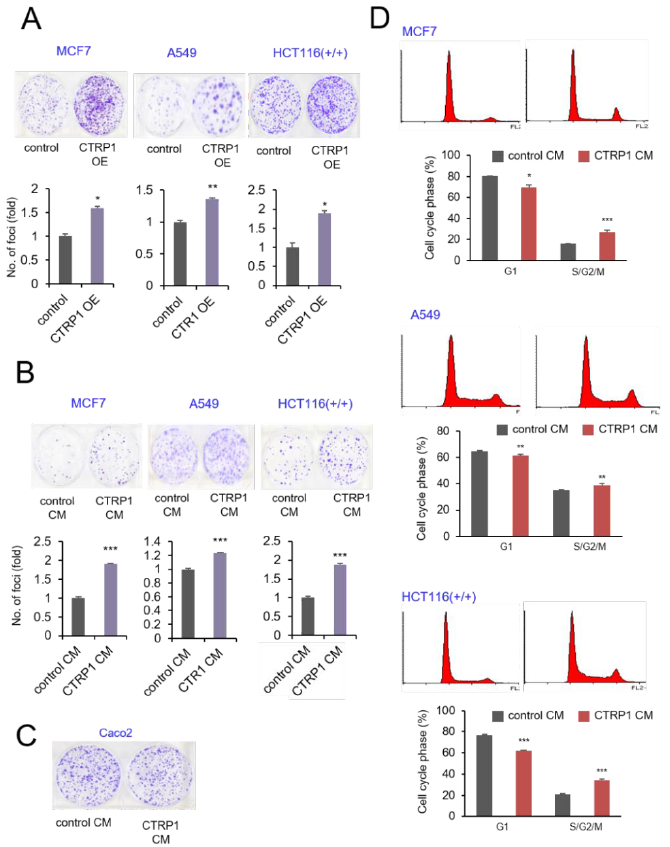
Figure 5. CTRP1 increases cell proliferation and migration of cancer cells. ( A ) CTRP1 overexpression increases cell proliferation. HCT116, MCF7, and A549 cells were infected with either control lentivirus or CTRP1 lentivirus. After puromycin selection, 1,000 cells were seeded and incubated for 10 days. After incubation, cell proliferation was measured by crystal violet assay. * p < 0.05, ** p < 0.01. ( B ) CTRP1 CM increase cell proliferation. HCT116, MCF7, and A549 cells were seeded at a density of 10 3 cells per well and incubated for 10 days with either control CM or CTRP1 CM. After 10 days of incubation, cells were measured by crystal violet assay. *** p < 0.005. ( C ) CTRP1 CM did not increase the cell proliferation in p53 null cells (Caco2). ( D ) CTRP1 CM enhances cell cycle progression. Control CM and CTRP1 CM were analyzed by flow cytometry, and the cell cycle population (%) were calculated and shown in the graph * p < 0.05, ** p < 0.01, *** p <